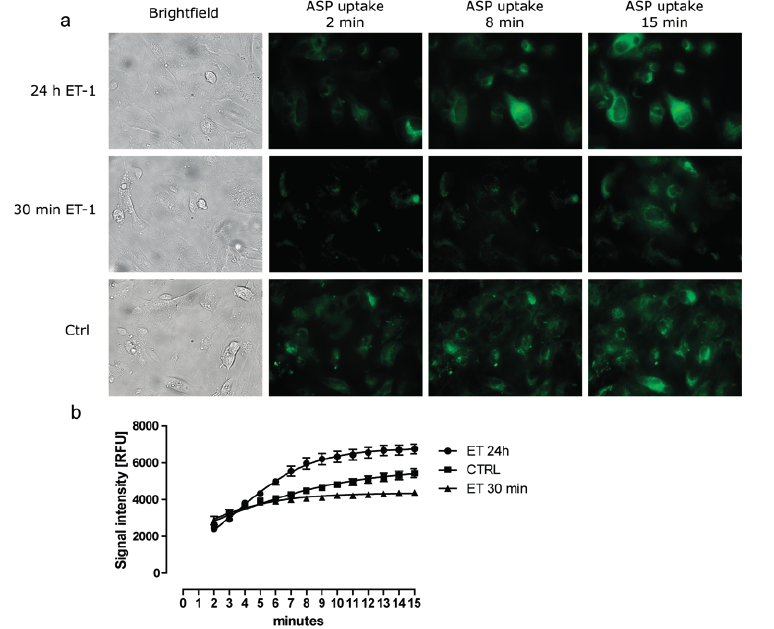
Figure 2. Changes in ASP + uptake by ciPTEC in response to exposure to ET-1. CiPTEC were incubated for 30 min or 24 h with 100 nM ET-1 before measuring the intracellular uptake of the fluorescent cationic compound ASP + (10 µM). ( a ) Representative confocal images of 24 h ET-1 exposed (top row), 30 min ET-1 exposed (middle row) or control cells (bottom row) taken at 2, 8 or 15 min after addition of ASP + ; ( b ) ASP + accumulation in cells was determined over the 15 min time period for 24 h ET-1 exposed ( ● ), 30 min ET-1 exposed ( ▲ ) or control cells ( ■ ). Fluorescence intensity over time was quantified